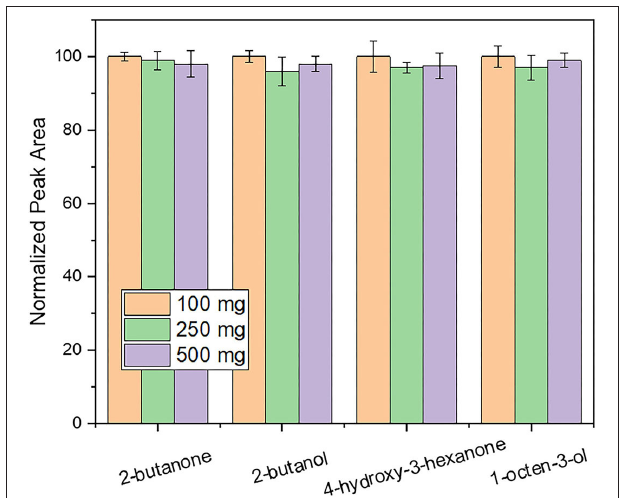
FIGURE 1 | Evaluation of the influence of sample mass on response using an extraction time of 30min and a desorption time of 5min. Other parameters as described in the experimental section.